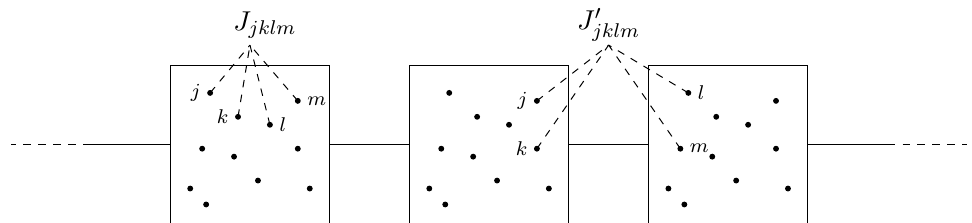
Figure 1. A chain of coupled SYK sites: each site contains N (cid:29) 1 fermion with SYK interaction. The coupling between nearest neighbor sites are four fermion interaction with two from each